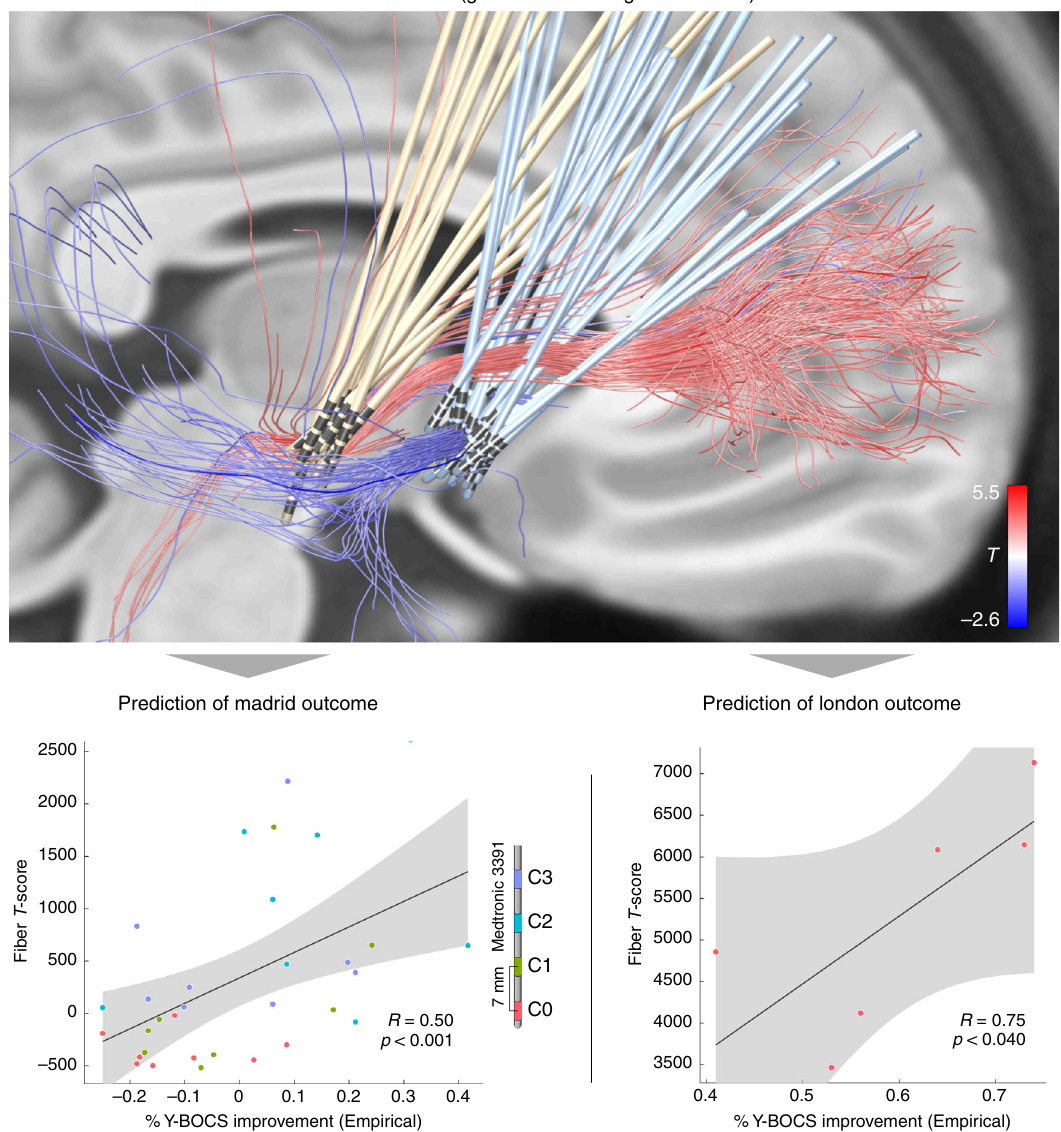
Fig. 4 Predictions in test cohorts. Top: predictive fi bers calculated on both training cohorts (Cologne & Grenoble) irrespective of their target. Red fi bers are positively associated with clinical improvement, blue fi bers negatively. Bottom: the sum of aggregated fi ber T -scores under each VTA predicted %-Y- BOCS improvements in eight patients with four settings each ( N = 32 stimulations) of the Madrid cohort (left) and six patients of the London cohort with dual stimulation (four electrodes) of STN and ALIC (right). Gray shaded areas represent 95% con fi dence intervals. Please note that p-values in this manuscript are based on random permutation testing. Based on classical tests, the result shown in the lower right panel would remain signi fi cant in a one- sided test, only ( p -one-sided = 0.044, p -two-sided = 0.089). A replication of this result based on anatomically prede fi ned pathways is shown in Supplementary Fig.